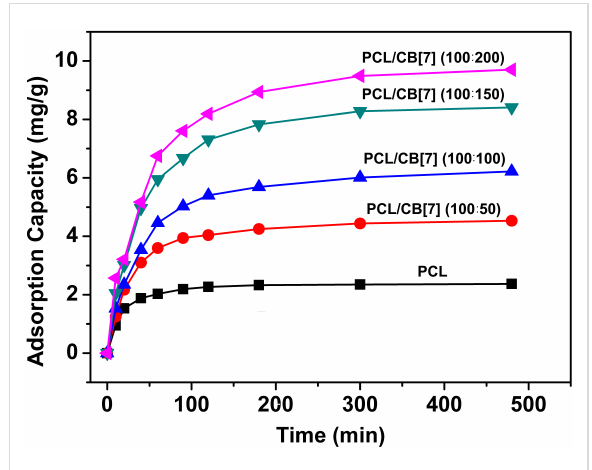
Figure 4: Adsorption kinetics curve of the adsorption of methylene blue (MB) by the electrospun nanofibrous membranes.